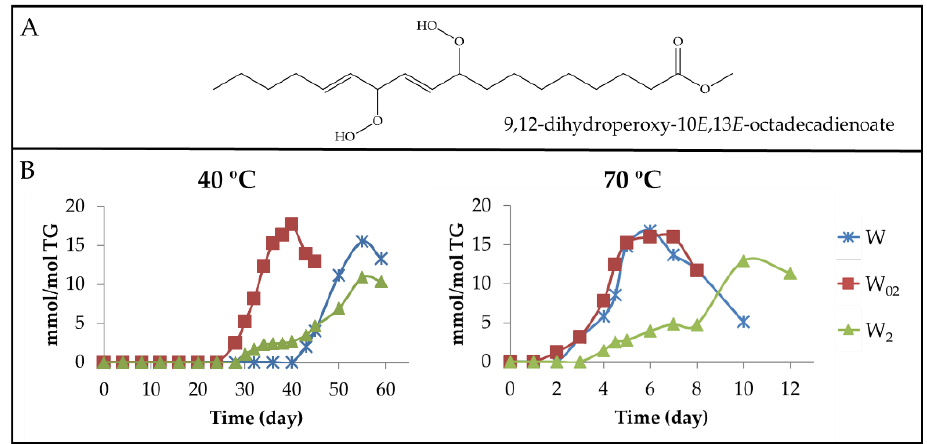
Figure 6. ( A ) Structure of 9,12-dihydroperoxy-10 E ,13 E -octadecadienoate as an example of a dHPO- nc( E , E )-dE. ( B ) Evolution of the concentration, expressed as mmol/mol TG, of dHPO-nc( E , E )-dEs in walnut oil samples with different enrichment levels of α T (W, W 02 and W 2 ), subjected to either 40 °C or 70 °C, up to advanced stages of the oxidation process.